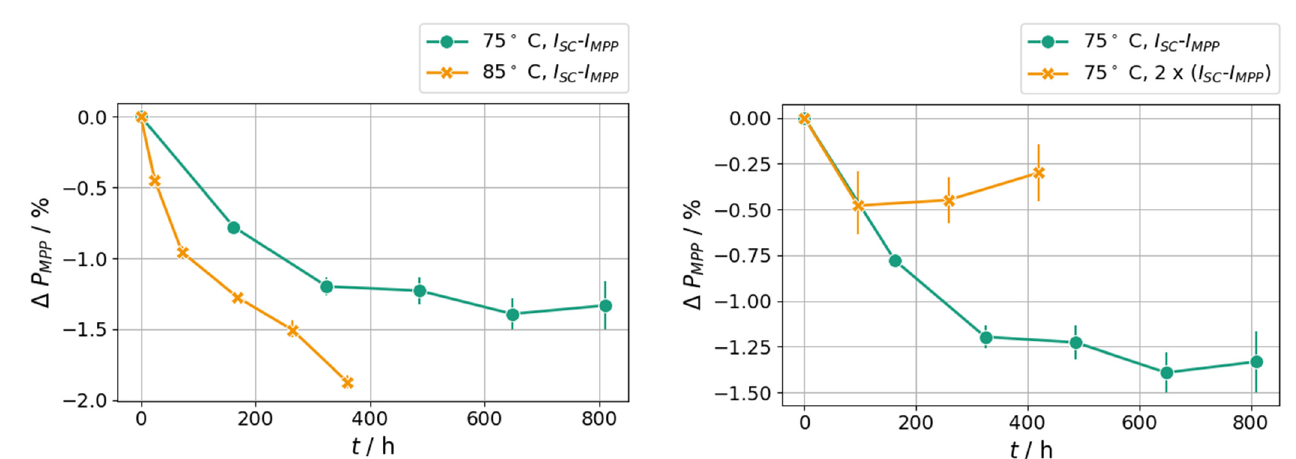
Fig. 9. Relative changes of P MPP at STC of PV modules during LETID testing at 75 ° C and MPP mode (M04, M05) and at 75 ° C and 2 × ( I SC (cid:3) I MPP ) (M08, M09). Average values over two modules; Error bars: min / max values of two modules.